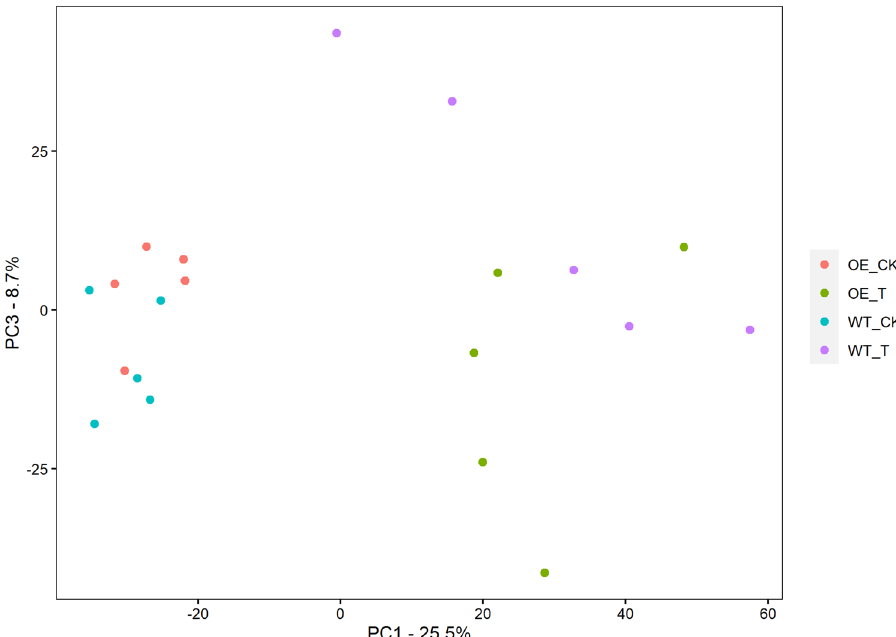
Figure 3. Principal component analysis (PCA) of metabolome profiling of the OsDRAP1 transgenic plants (OE-7) and wild type (WT) with five replicates under normal growth condition and salt stress treatment for 24 h. “CK” and “T” represent the plants under normal condition and salt stress,